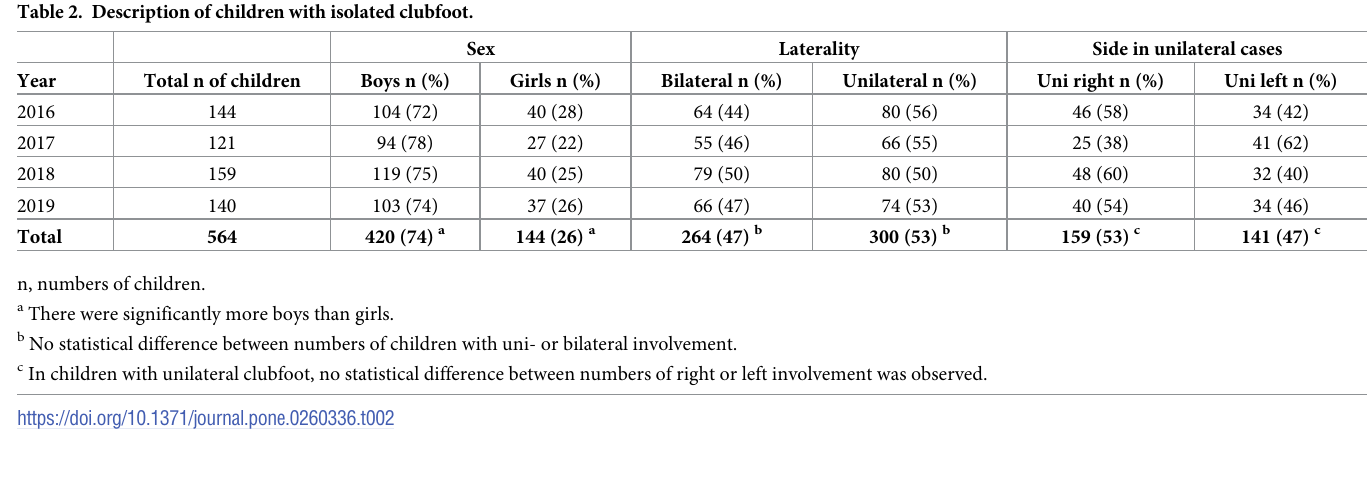
indicating no significant statistical difference between numbers of children with uni- or bilat- eral involvement. There was no statistically significant difference between the numbers of chil- dren with left- (47%) or right- (53%) sided unilateral involvement (mean diff. 0.03 [95% CI – 0.03 to 0.09]) (Table 2).